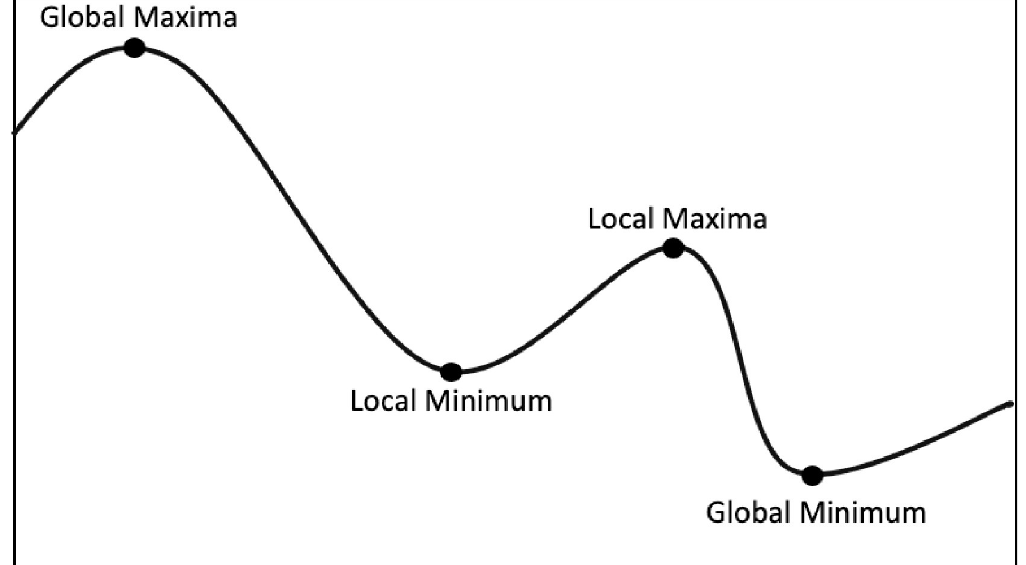
Fig 30. QA sample: Normal distribution for n = 50 and N = 60.